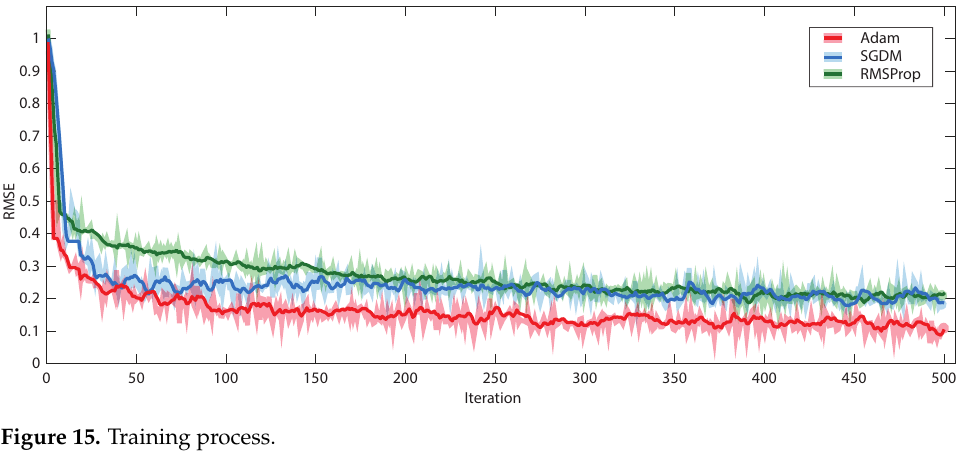
Figure 15. Training process.